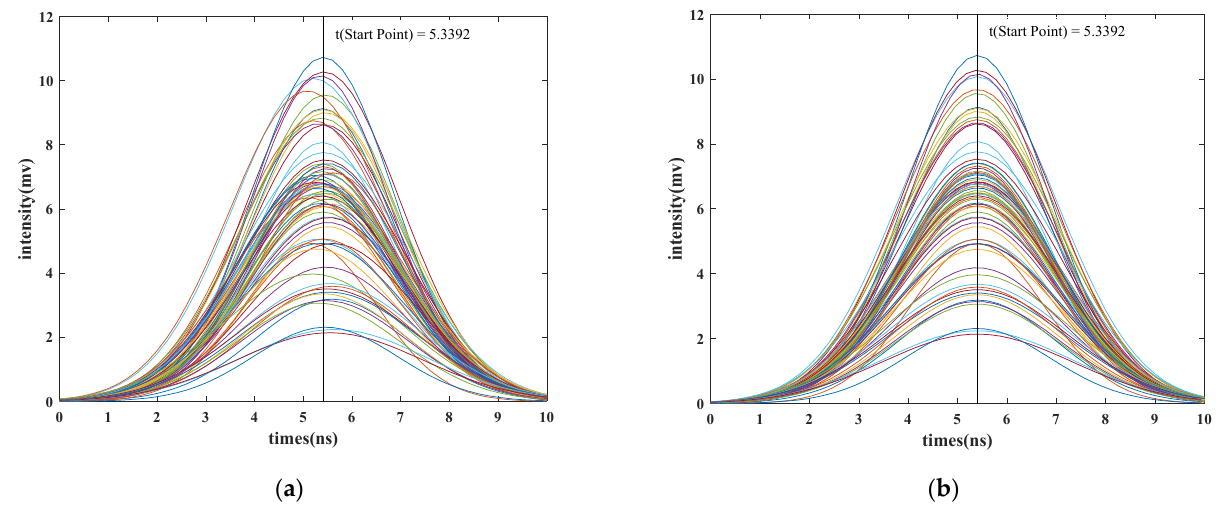
Figure 6. Launching time calibration: ( a ) initial irregular transmitter pulse of each channel before calibration; ( b ) regular transmitter pulse of each channel after calibration. Table 3. Starting position of each channel and maximum offset.